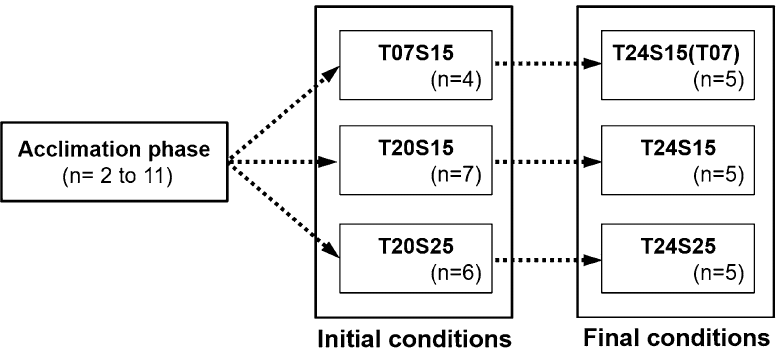
Figure 1. Flowchart of experimental procedures. In the left box, n indicates the number of generations under acclimation phase (n = 2 for T = 7 °C and n = 10 or 11 for T = 20 °C). The two larger boxes correspond to the initial (left) and final (right) conditions. For each condition TXSY indicated that temperature was set to X °C and salinity to Y PSU. Two conditions were realized at T = 24 °C and S = 15PSU, to make a distinction the heat shock treatment was designed T24S15(07). In both boxes n indicates the number of generations followed at each